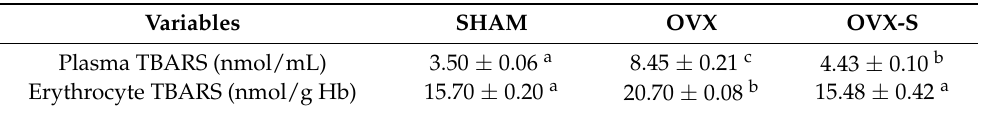
Table 4. Changes in plasma and erythrocyte TBARS of Superjami rice bran extract supplementation diet in ovariectomized rats.